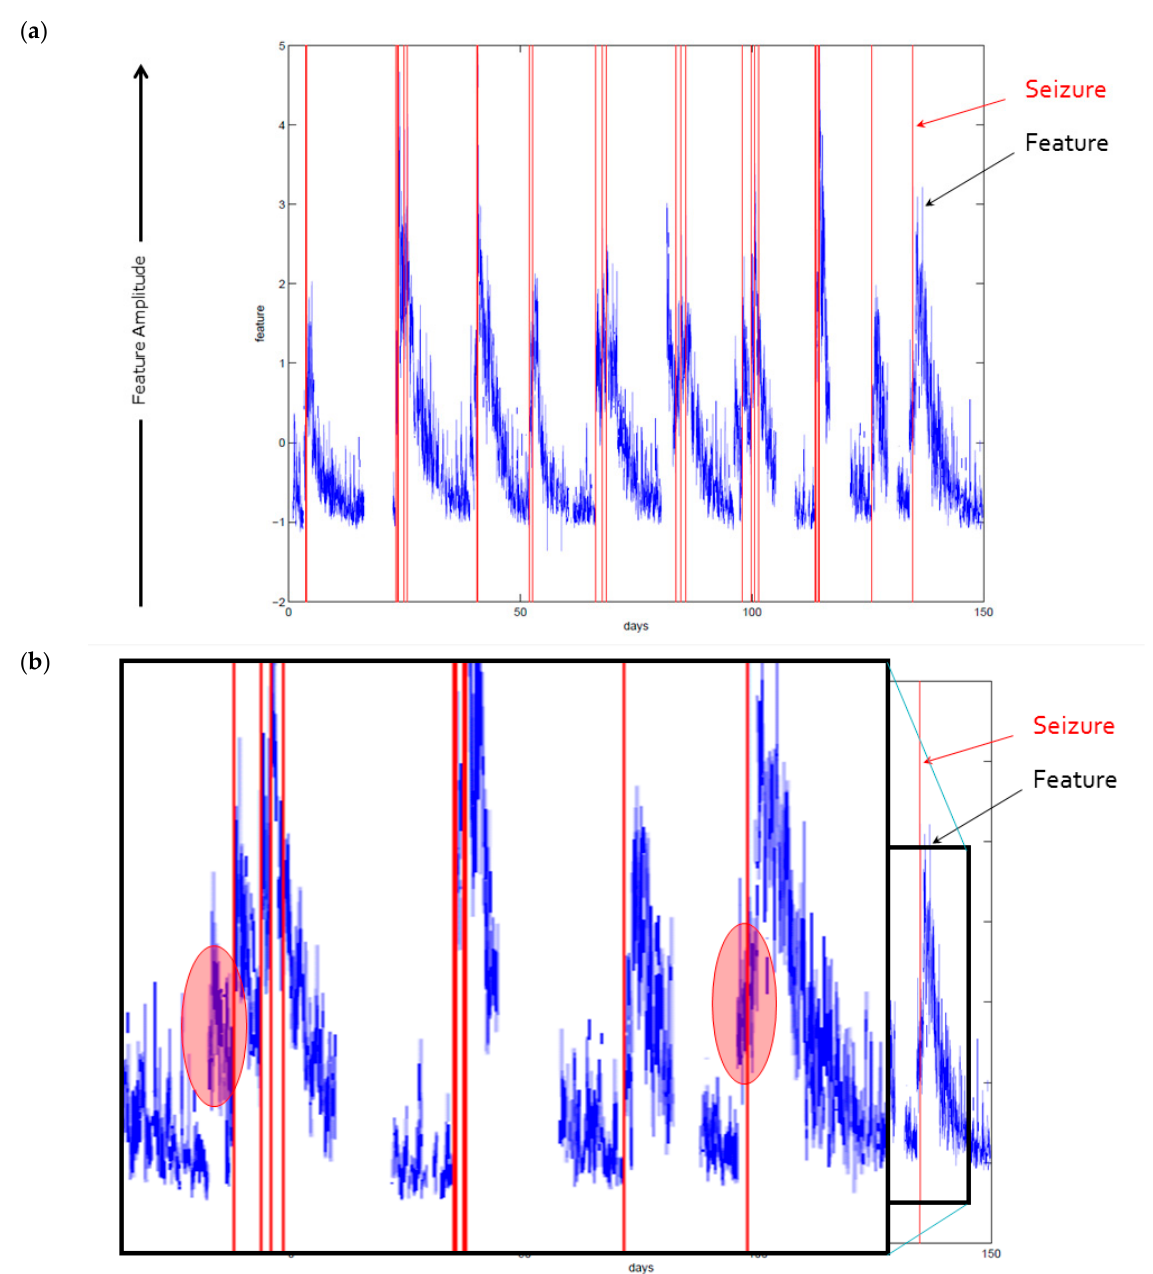
Figure 5. ( a ): Example feature shown over 150-day span. The feature is shown as a continuous value in blue, and seizure vents are marked as discrete vertical lines in red. Though in this feature, post-ictal changes are apparent for extended durations following each seizure, shorter interval yet detectable and actionable changes are also seen preceding the seizures. ( b ): A magnified portion of the feature plot is shown as an inset. In the two regions highlighted with a partially transparent red oval, changes in the feature are evident prior to the onset of the